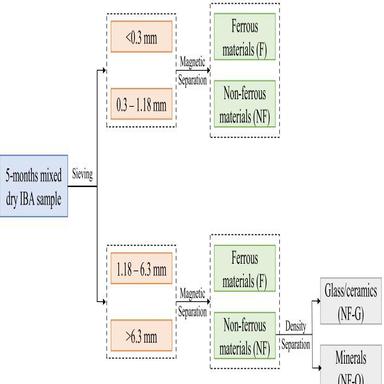
Flowchart for IBA sorting used in the current study.